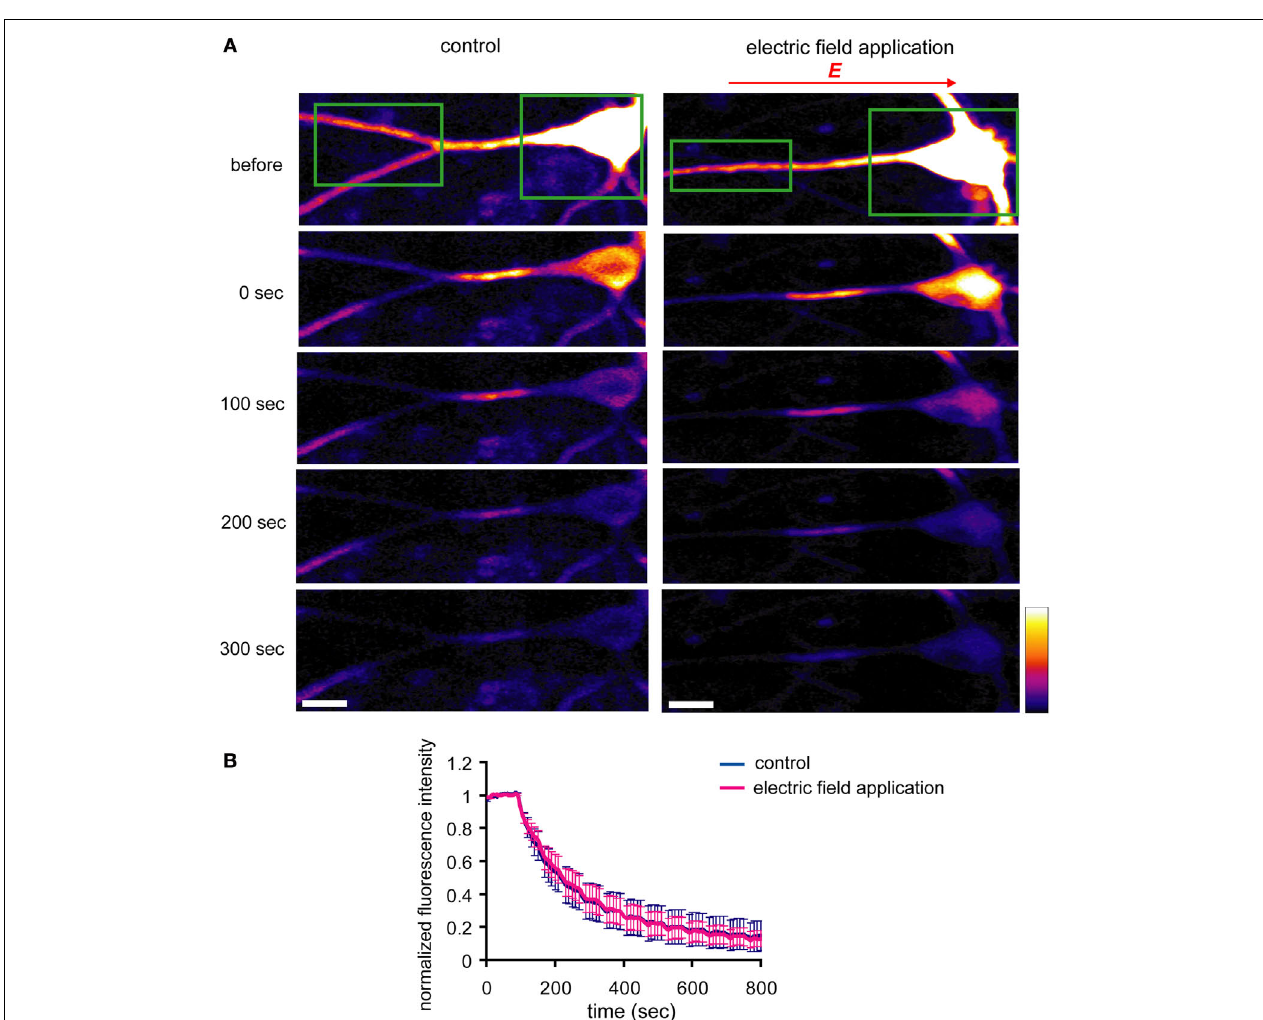
signifi cantly infl uenced mEPSC frequency in a direction-sensitive manner (* p < 0.05) ( n = 14 for each group) (scale bar = 10 pA, 500 ms). No apparent difference in membrane properties was observed between experimental groups ( Table 1 ).